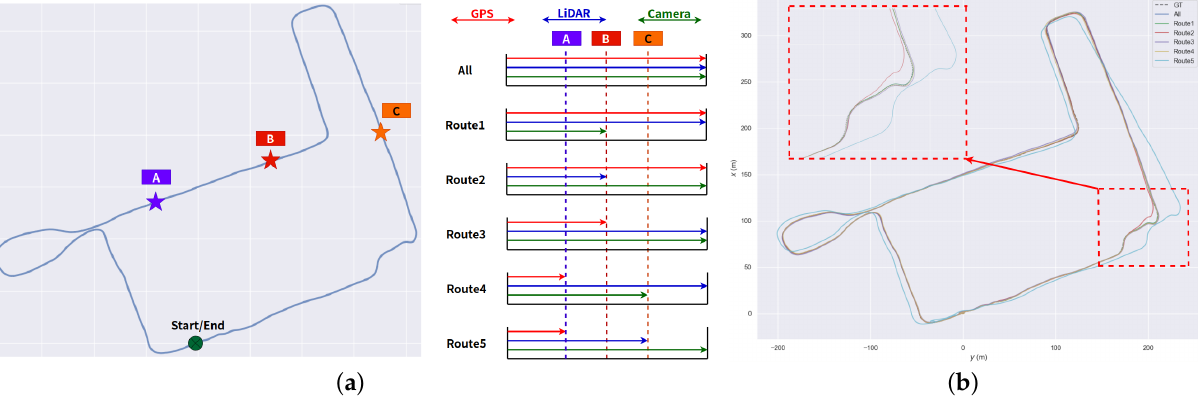
Figure 15. ( a ) Three locations throughout the trajectory to disable the camera, LiDAR, and GPS. ( b ) The trajectory result of our system when one or more sensors are